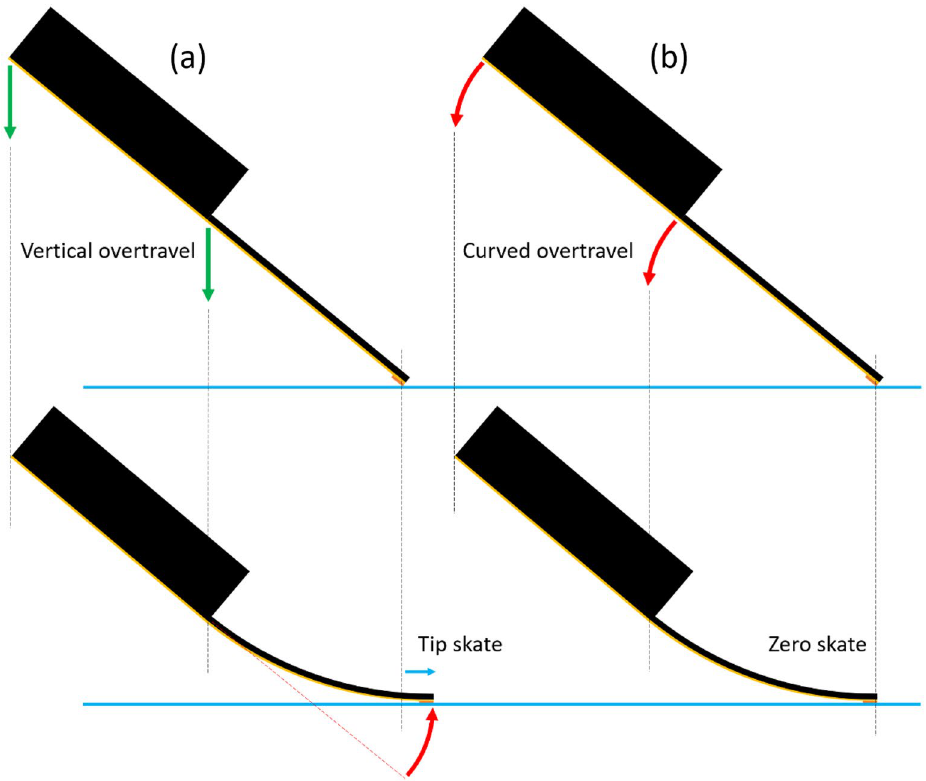
Figure 17. Zero skate of tapered probes based on a triangular cantilever achieved using skate compensation. ( a ) Vertical overtravel (green arrows) of the rigid support chip results in tip skate (blue arrow) when the tip of the cantilever follows an arc (red arrow). ( b ) Curved overtravel (red arrows) of the rigid support chip results in zero